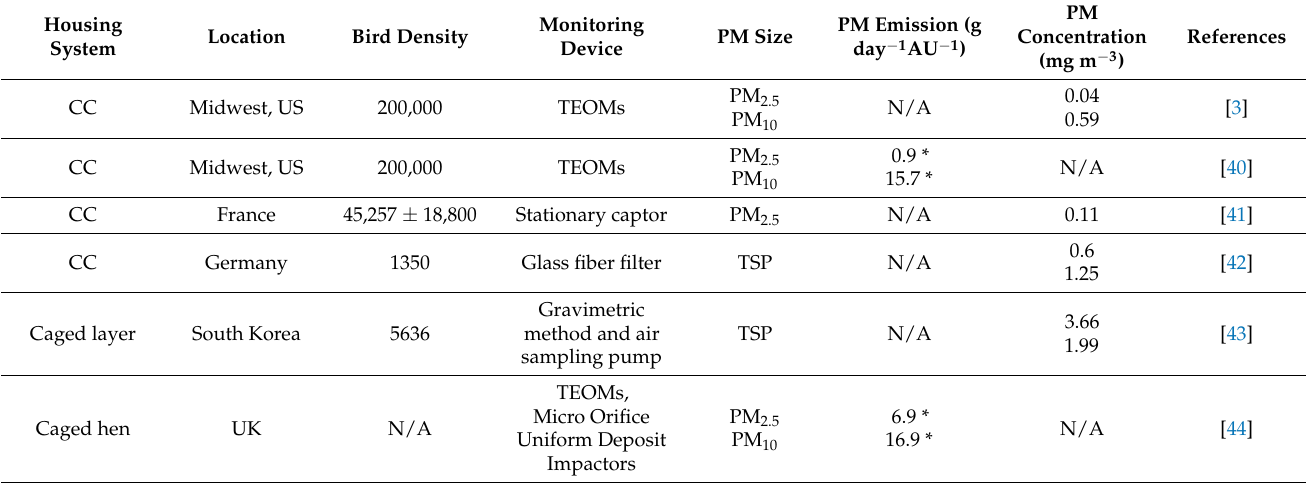
Table 2. Particulate matter emissions and concentration of different PM sizes in various poultry housing systems.